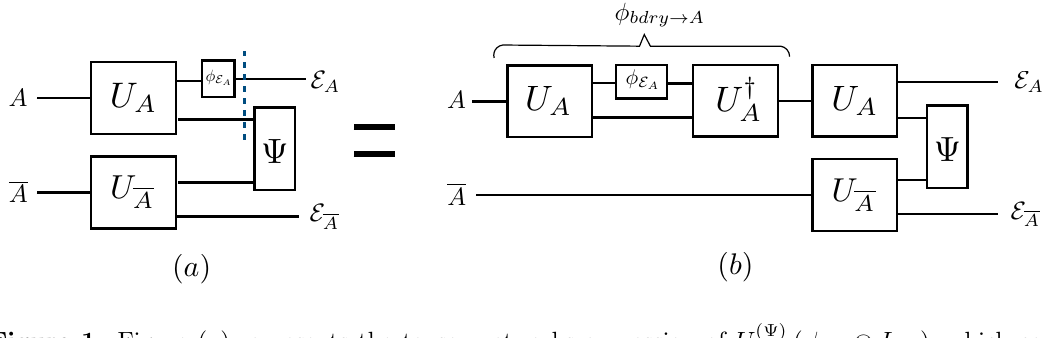
( (cid:30) I ), which cor- code E A (cid:10) E A . Inserting I I = U y U A on the dashed line in ( gr ) code j i bdry A E A (cid:10) A E code j i bdry